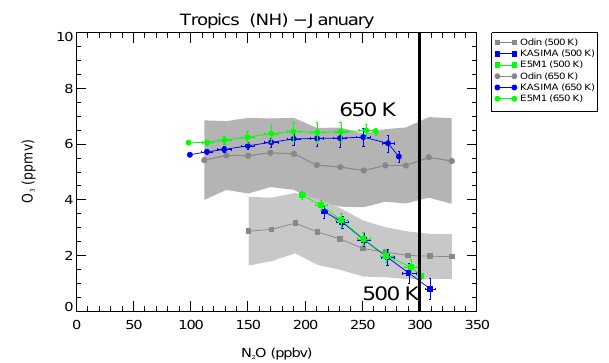
Fig. 2. Comparison of monthly averages of N 2 O and O 3 derived from KASIMA (blue) and E5M1 T40L90MA (green) with Odin/SMR (grey) at 500 ± 25K and 650 ± 25K in the Northern Hemisphere tropics (0–30 ◦ N, January 2003). The grey shaded area marks the range of the standard deviations of the monthly averages derived from Odin/SMR. The black solid line marks where N 2 O mixing ratios exceed